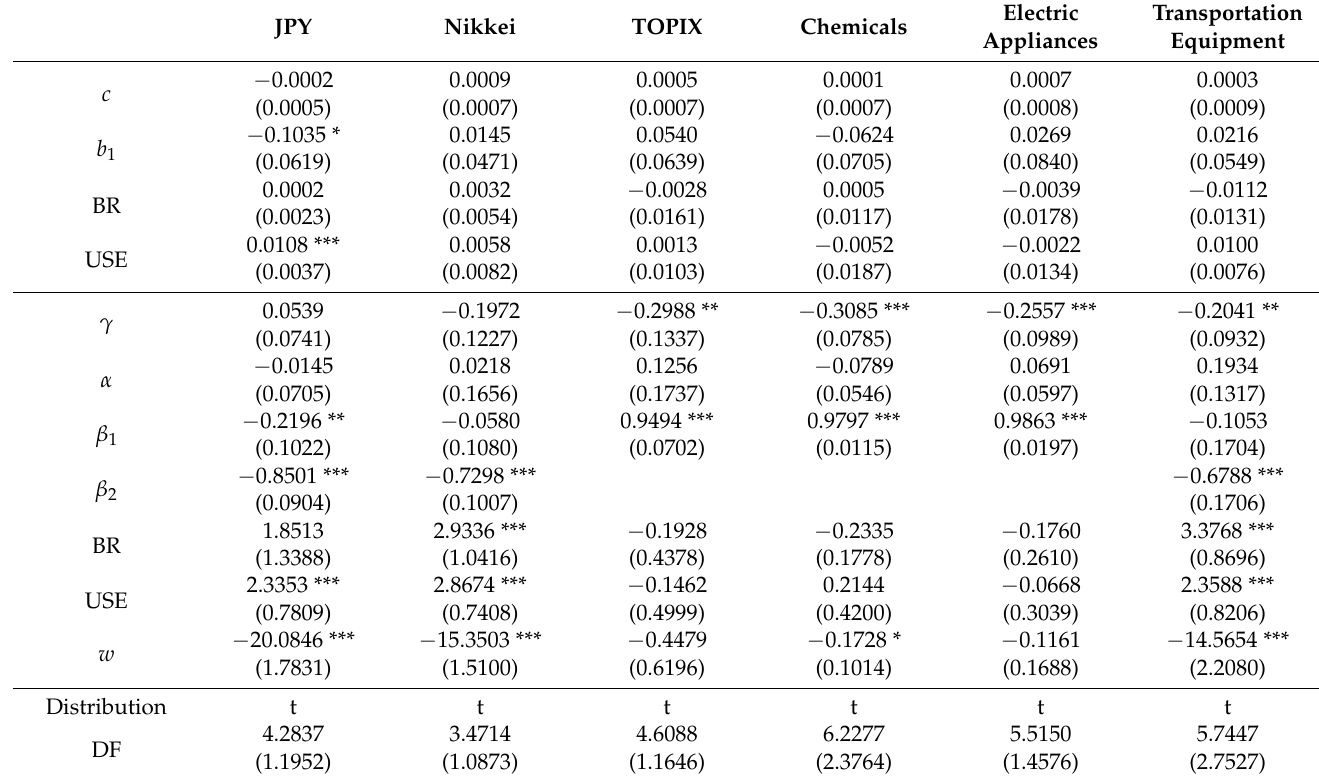
Table 9. EGARCH estimation with dummy variables for BR and USE. Author’s estimations based on the data from the Bank of Japan, TSE and Yahoo Finance. The numbers in parentheses are standard errors. ***, ** and * indicate significance at the 1%, 5% and 10% levels, respectively. Distribution is Student’s t. DF means the degree of